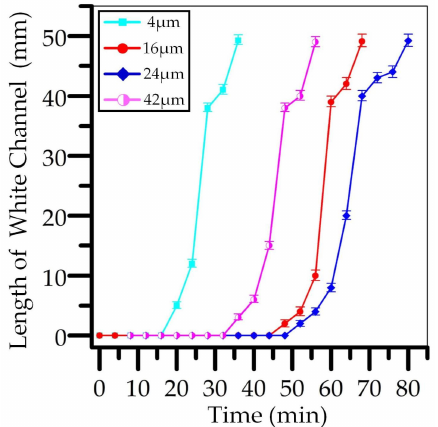
Figure 8. The time variation trends of the white channel length under different